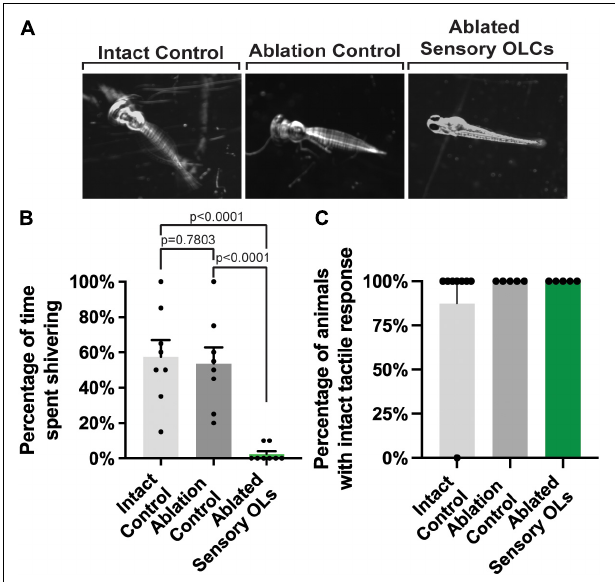
FIGURE 8 | Sensory-related OLC ablation disrupts sensory behavior. (A) Images of three timepoints from a 20 s movies overlayed as a maximum projection in intact, ablation control, and ablated sensory OL animals showing the change in twitching behavior in sensory OL ablated animals upon exposure to cold water treatment. (B) Quantification of the percentage of time intact, ablated control, and sensory OL ablated animals spent shivering upon exposure to cold water treatment ( p < 0.0001, p = 0.7803, p < 0.0001). (C) Quantification of the percentage of intact, ablated, or sensory-related OLC ablated animals the exhibited a tactile response. All images are orientated anterior to left, posterior to right, dorsal up and ventral down.